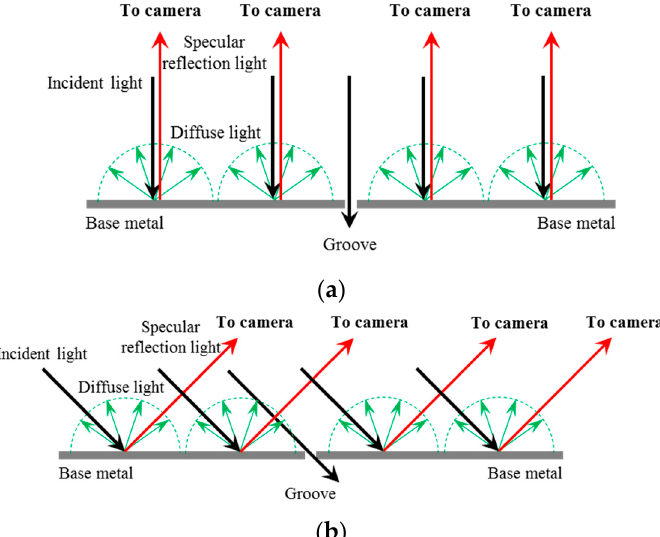
Figure 3. The reflection characteristic differences between the groove and the base metal. ( a ) The incident light is normal to the surface of the base metal; ( b ) The incident light is not normal to the surface of the base metal.